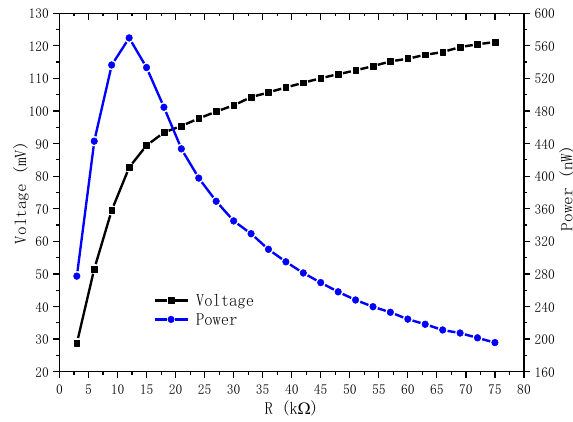
Figure 12. Curves of voltage and power.